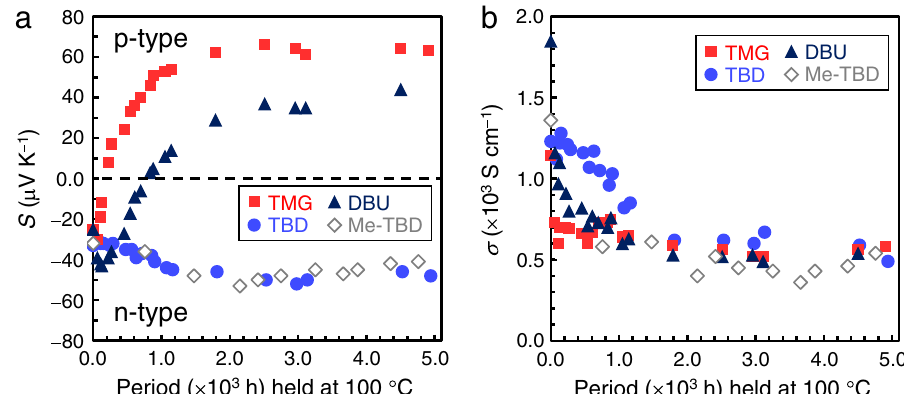
Fig. 6 Long-term stability of n-doped EC1.5-CNT fi lms during incubation at 100 °C in air. a Changes in Seebeck coef fi cient ( S ). b Changes in electrical conductivity ( σ ). Both parameters were measured along the in-plane direction of the fi lm. All measurements were performed at 25 °C in air. Specimens were prepared by immersing EC1.5-CNT buckypapers in the DMF solutions of DBU, TBD, Me-TBD, and TMG with concentrations of 545, 71, 71, and 769 mM,